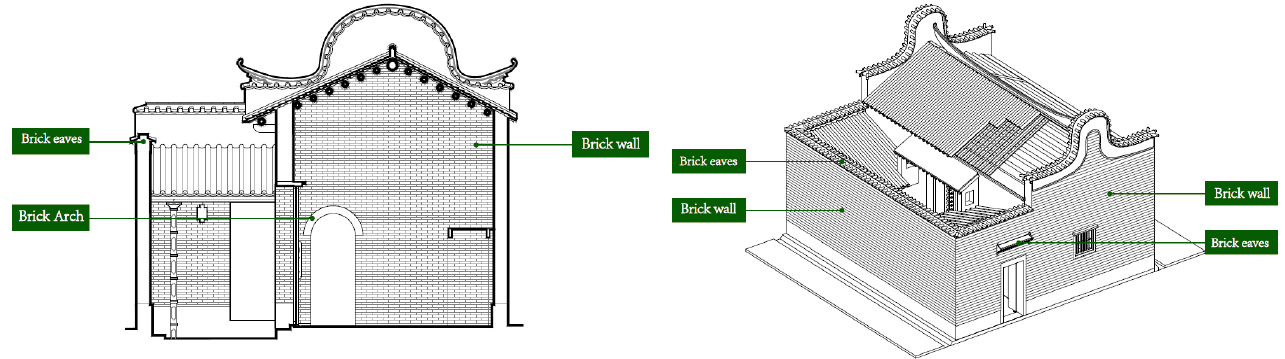
Figure 2. Application of gray bricks in Macau’s historical buildings. (Image Source: Atlas of Restoration of Historic Buildings in Guangzhou; annotations are added by author drawing).